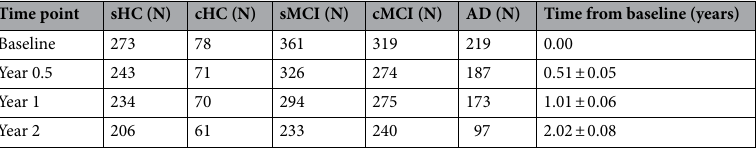
Table 2. Number of scans per time point by clinical group and time between scans. Time from baseline values are in mean ± standard deviation.